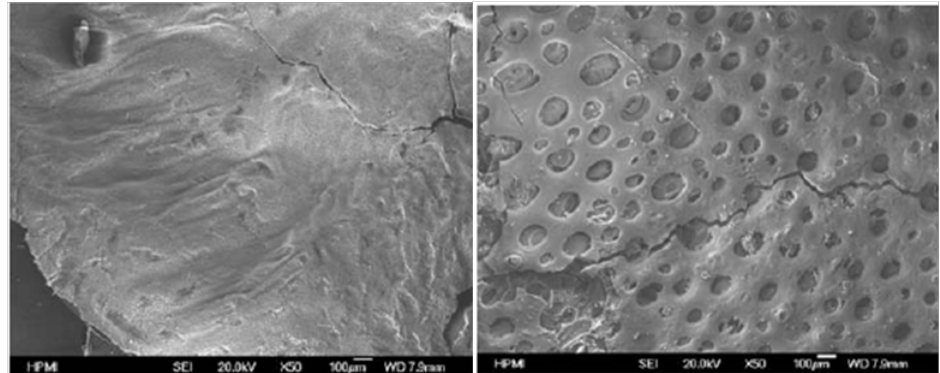
Figure 4. SEM micrographs of residues for Epoxy/POSS[Al] (left) and Epoxy/POSS